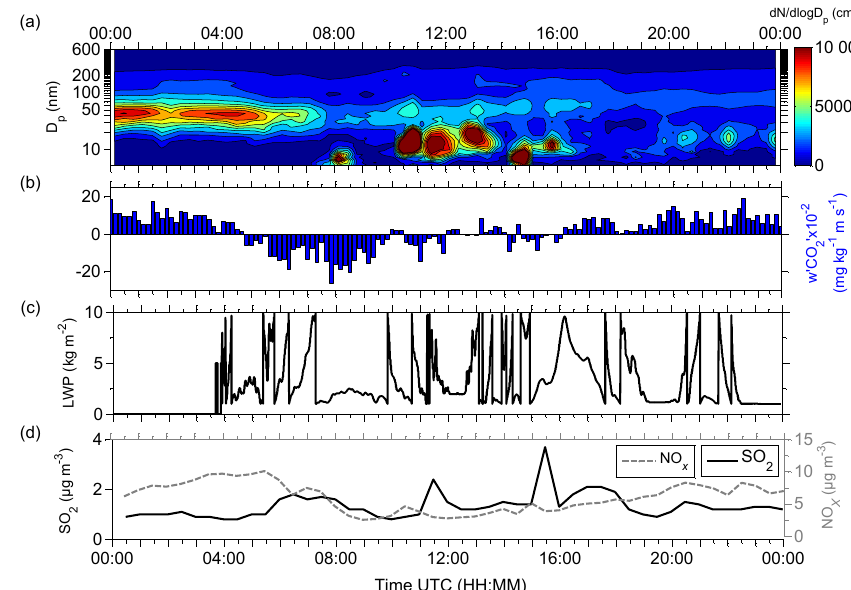
Figure 6. (a) Particle size distribution measured with TSMPS, (b) fluxes of CO 2 , (c) liquid water path, LWP and (d) gas concentrations of SO 2 and NO x during the MelCol experiment on 21 June 2015. The homogeneous aerosol load was affected by ABL growth after 07:30UTC and six sporadic formation events (seen in red dots in the size range of 10 to 20nm) were indicated during daytime between 08:10 and 16:10UTC under cloudy conditions and south-westerly